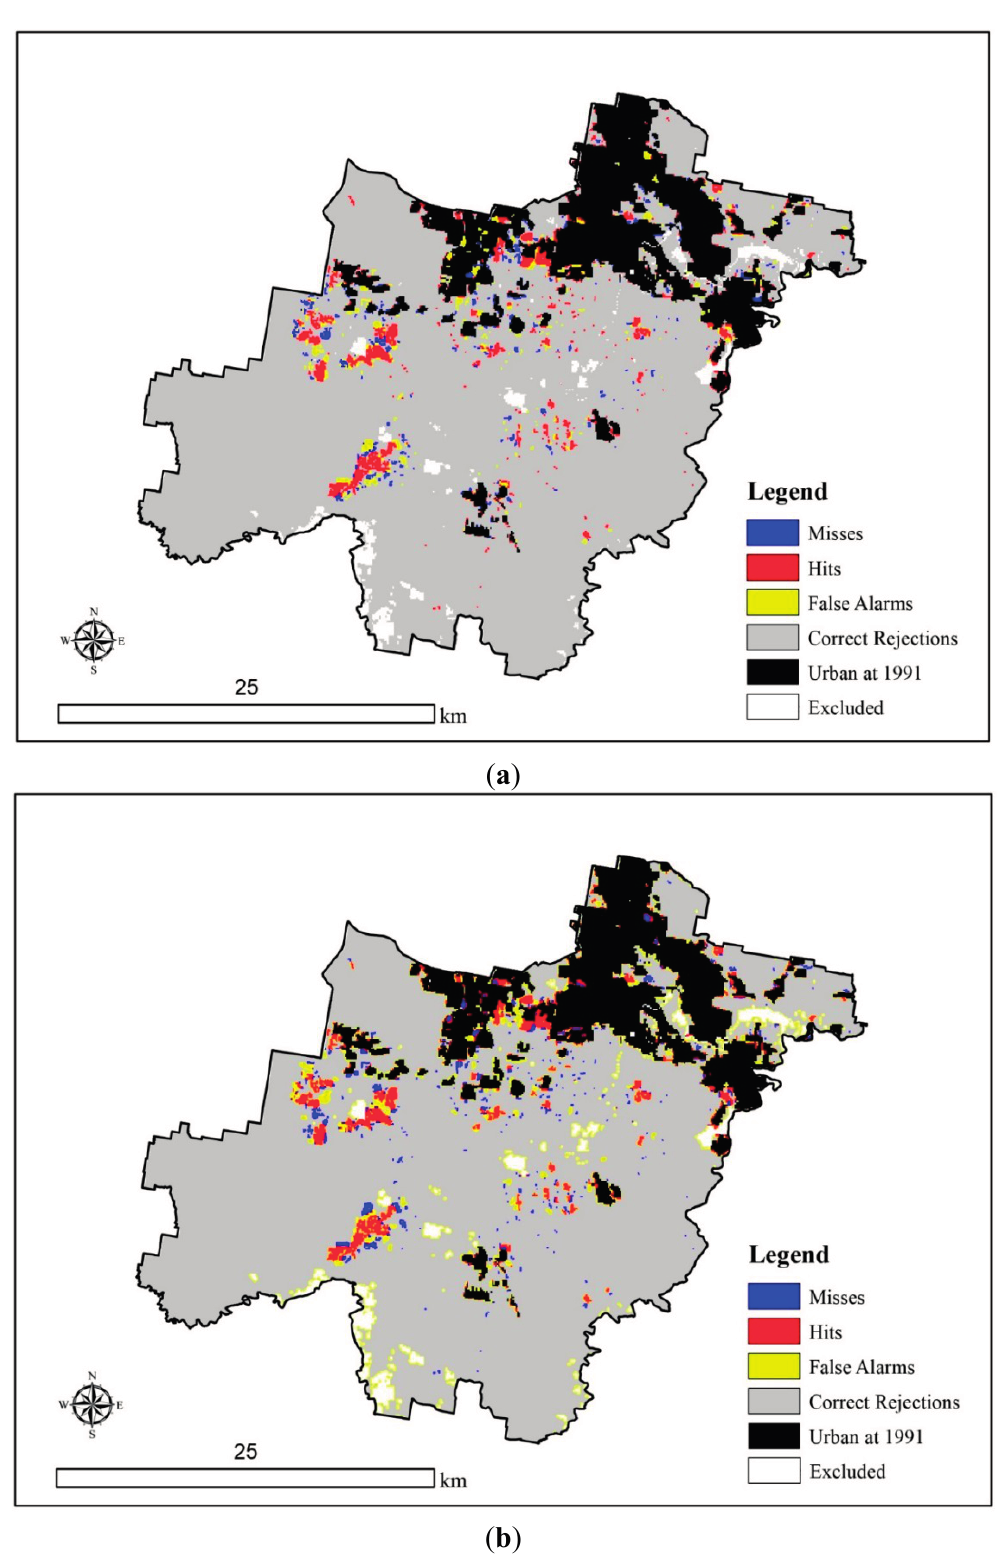
Figure 7. Simulation correctness and error based on the reference growth versus the simulated growth during 1991–2001. ( a ) The simulation correctness and error by the SAGA-CA model; ( b ) the simulation correctness and error by the logistic-CA model without SAGA